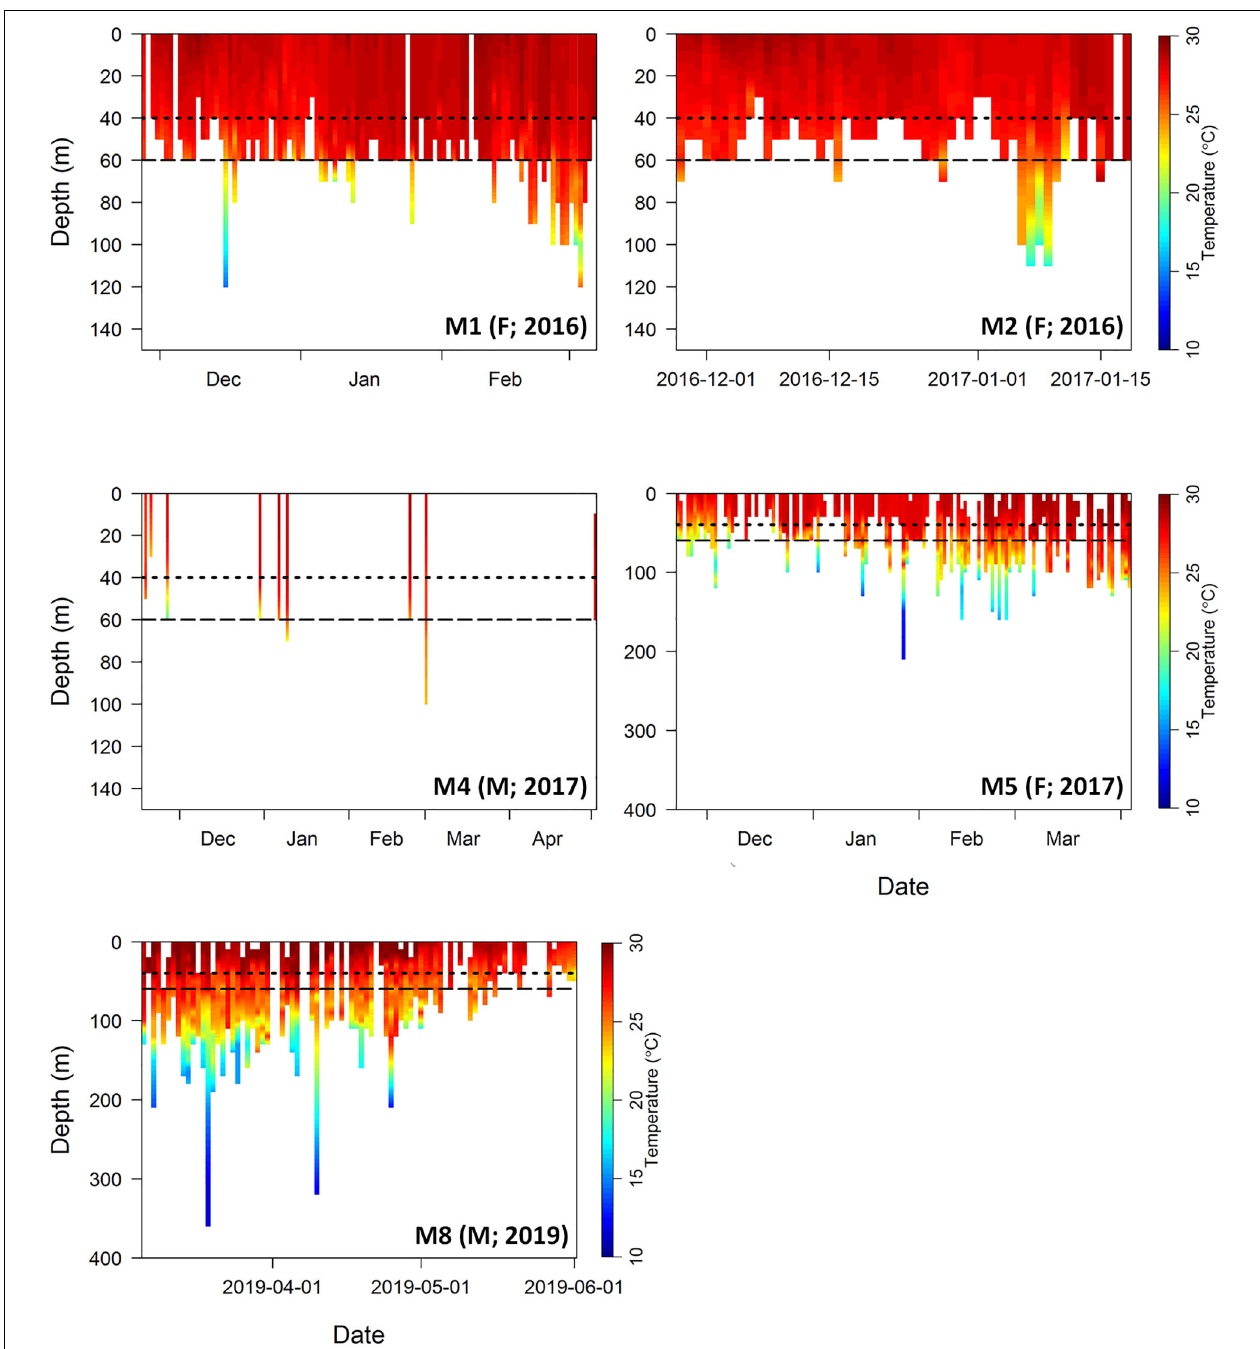
FIGURE 6 | Combined depth and temperature profiles for five reef manta rays ( Mobula alfredi ) tagged with archival pop-up satellite tags in Seychelles. Data interpolated from archived time series data (10 min intervals) for each day of data retrieved per tag. Depth data presented in 10 m bins and temperature data interpolated at a resolution of 0.5 ◦ C. Gaps indicate data that were not retrieved from the tag prior to tag battery depletion. Manta identification number (M ∗ ), sex (F, female; M, male), and year of tag deployment indicated in lower right of each panel. Dotted line represents average depth of the Amirantes Bank (40 m), and dashed line represents average depth of St. Joseph Channel (60 m) located between D’Arros Island and St. Joseph Atoll. Note variable depth scale on y